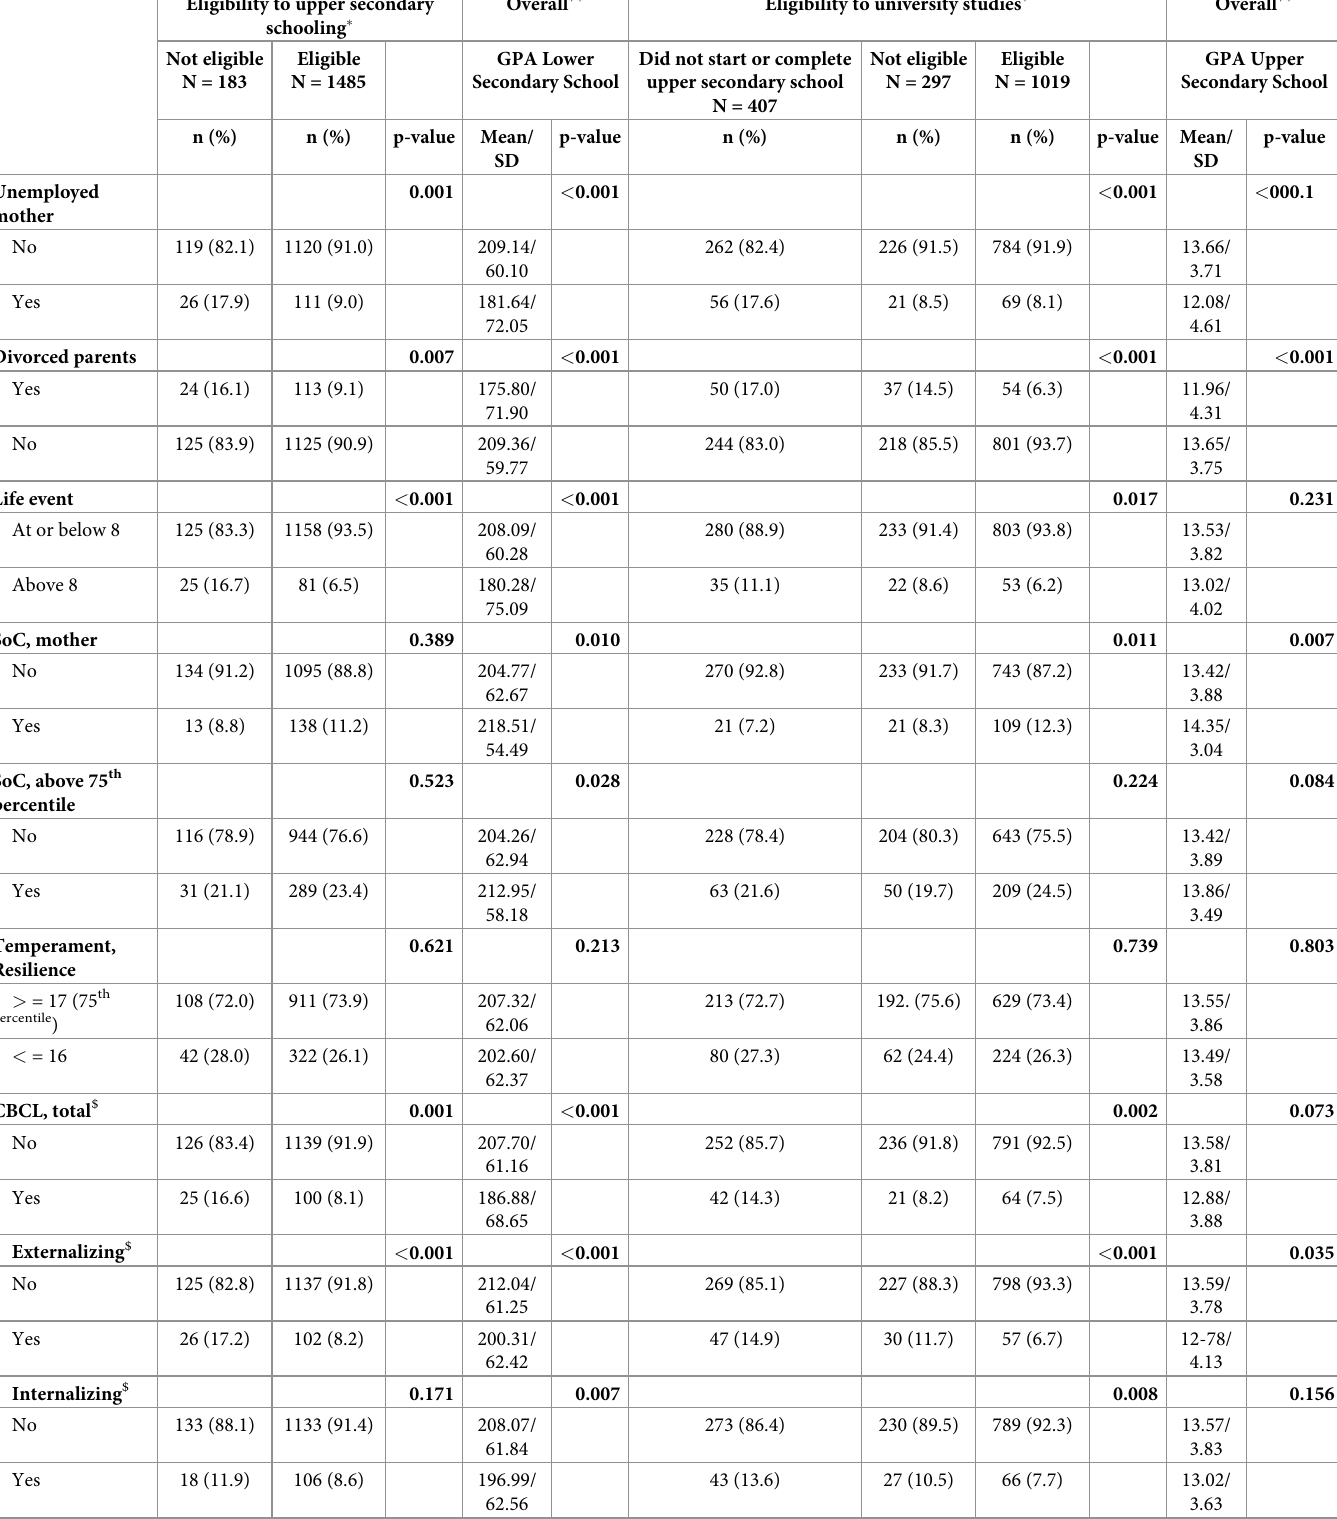
Table 2. Factors at the 3-year